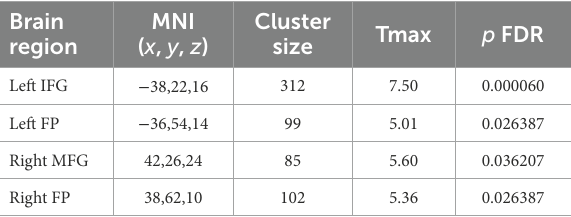
TABLE 2 Correlations with FBG variables in T2DM